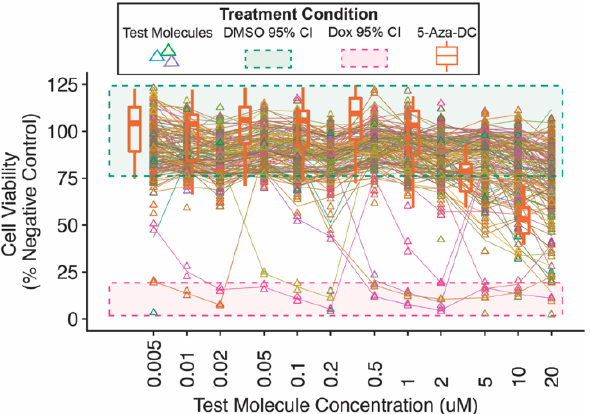
Figure 5. Secondary screen neural progenitor cell viability. Reporter neural progenitor cells (NPCs) were treated for 72 h with candidate molecules, 5-aza-2 ′ -deoxycytidine (5-Aza-DC, positive control) or doxorubicin (kill control), or DMSO (vehicle). NPCs treated with each concentration of candidate molecule were counter-screened for cell viability.